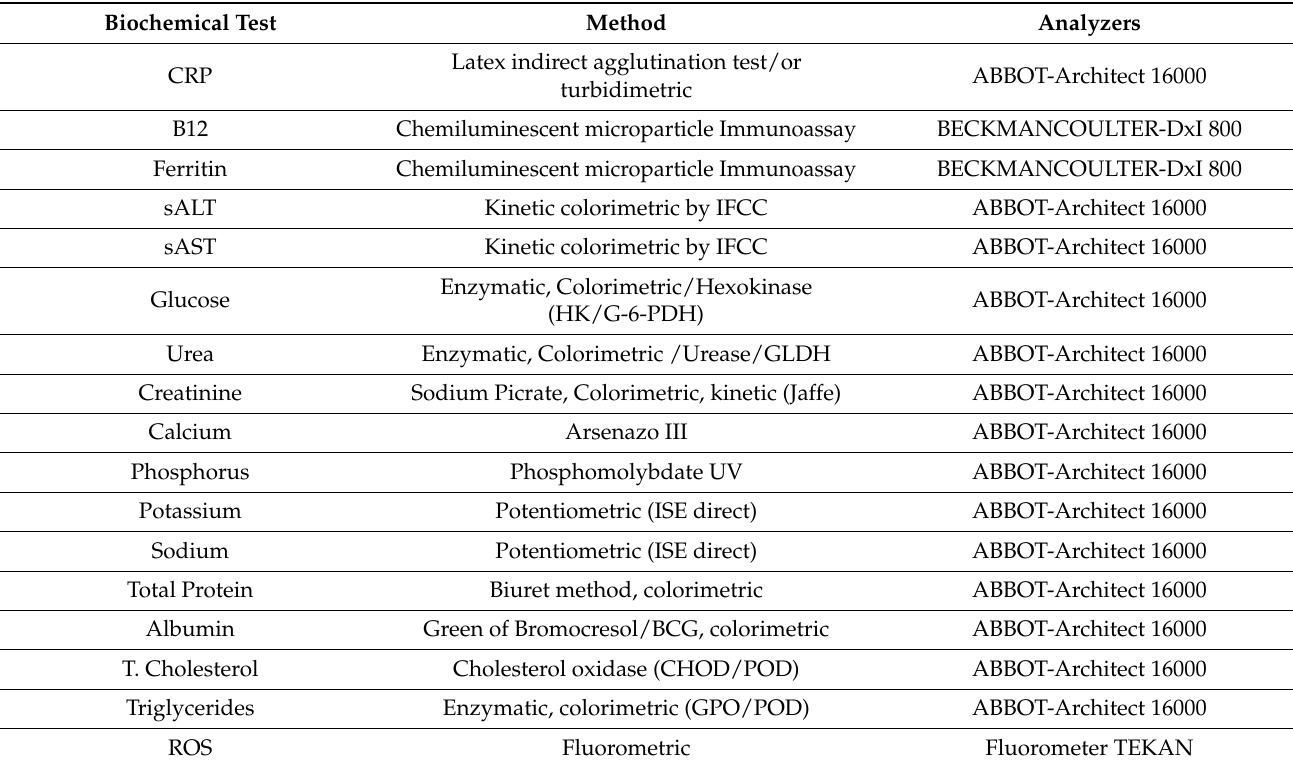
Table 2. Methods and analyzer used to measure the biochemical